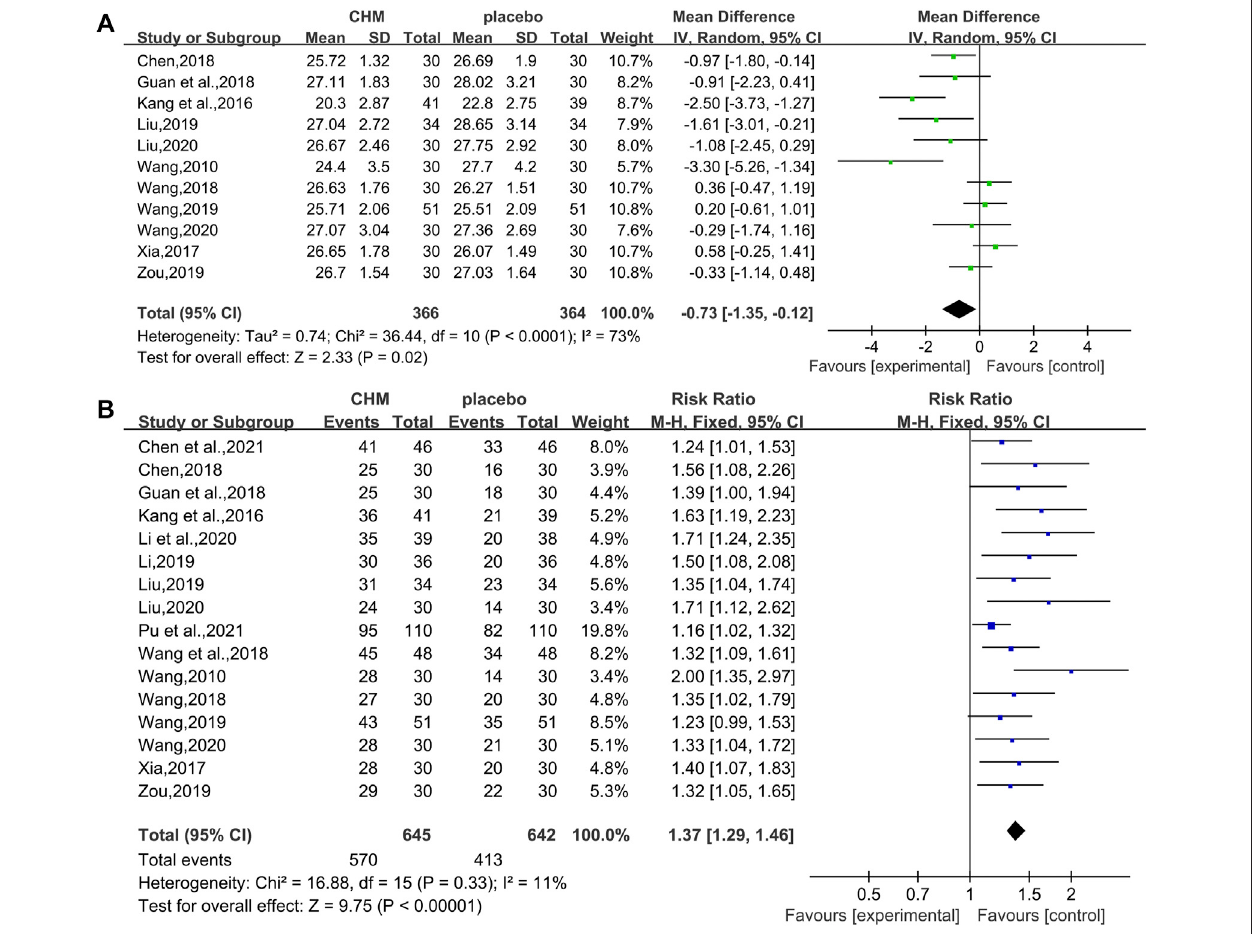
Frontiers in Pharmacology |